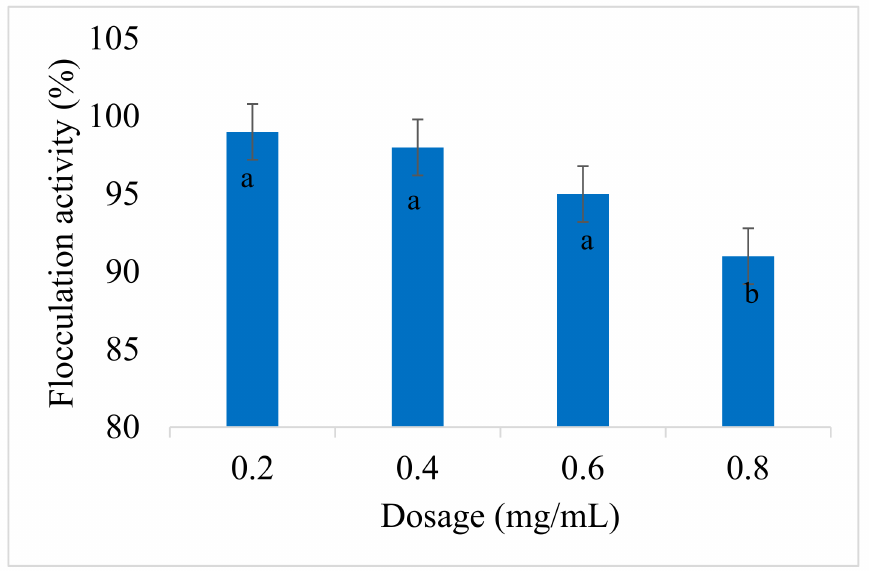
Figure 5. Effect of nanoparticles on flocculation activity. Different letters (a and b) denote statistical significance at p < 0.05.